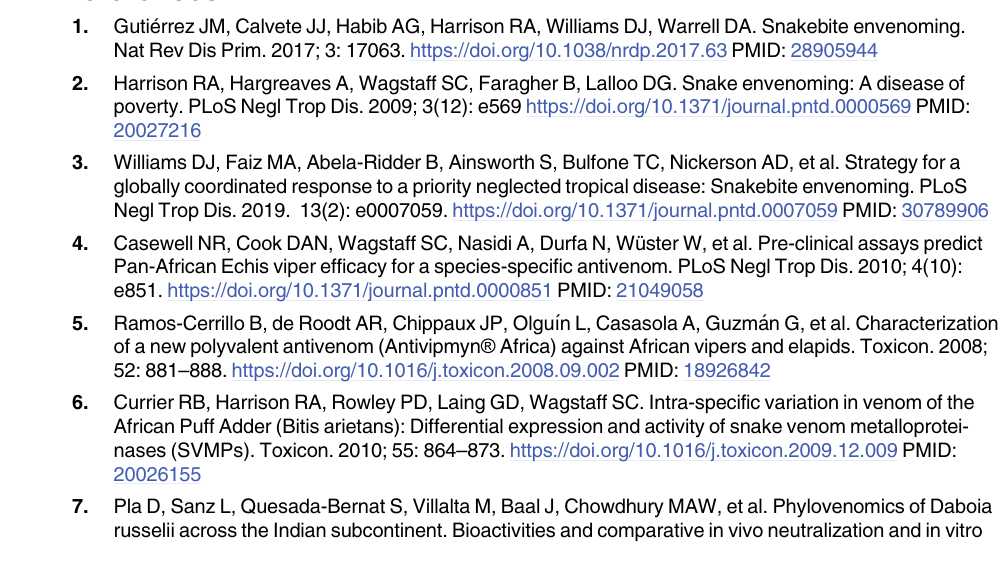
S1 Table. List of all ED values reported in identified studies. 50 S2 Table. List of total protein contents of antivenoms investigated in this study. (XLSX) S3 Table. List of all LD values reported in identified 50